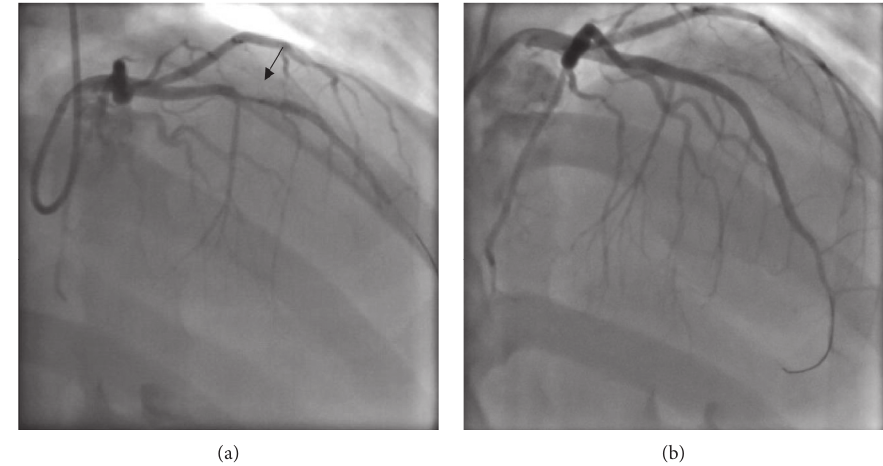
Figure 4: The patient’s LAD thrombus (black arrow) (a) before and (b) after catheterization. Diagnostic angiography done prior to catheterization demonstrated complete midsegment occlusion of the LAD with no significant disease noted in the left main circumflex artery and the right coronary